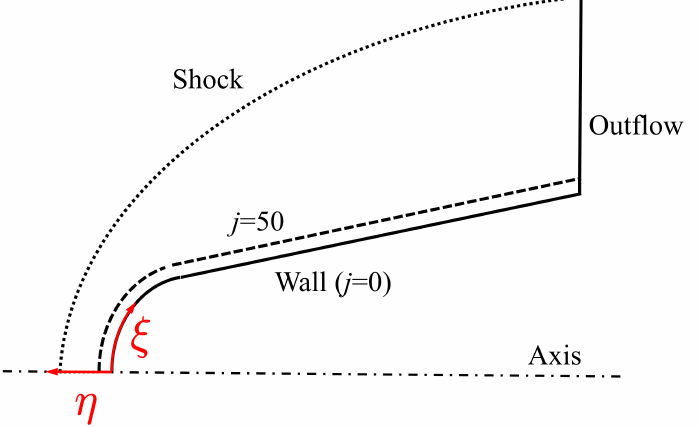
Figure 8. Schematic diagram of different regions.